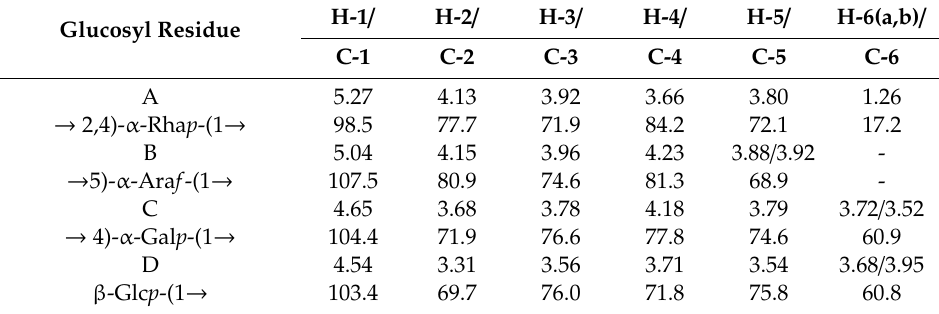
Table 5. The 1 H-NMR and 13 C-NMR chemical shifts of PCp-I. H-1 Glucosyl Residue